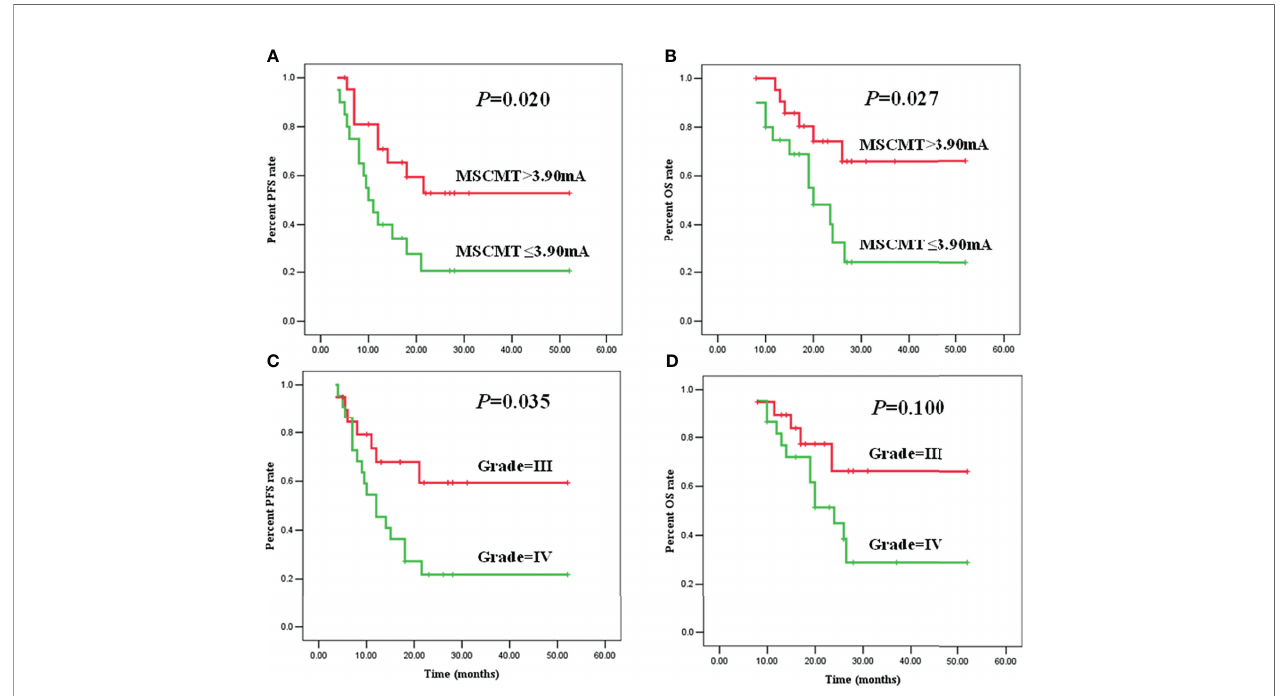
FIGURE 3 | Minimal subcortical monopolar threshold (MSCMT) predicted shorter progression-free survival (PFS) [ (A) , P = 0.020] and overall survival (OS) [ (B) , P = 0.027]. Higher tumor grade (IV/III) predicted shorter PFS [ (C) , P = 0.035] and OS [ (D) , P =